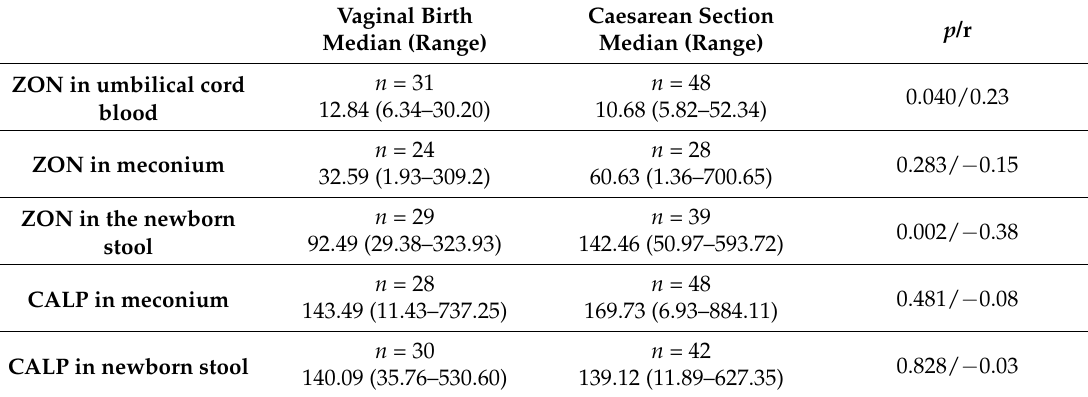
Table 6. Effectsofdeliverymethodonzonulin(ZON,ng/mL)andcalprotectin(CALP, µ